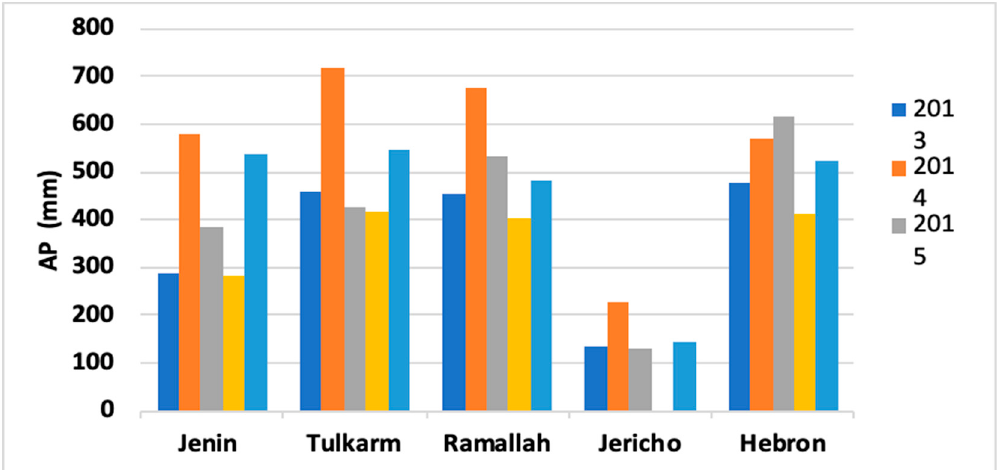
Figure 2. Annual precipitation (AP) in the period 2013–2015.